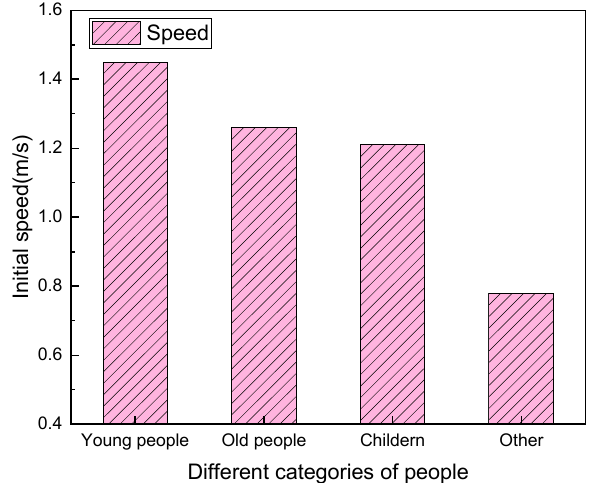
Figure 2. Average speeds of people of different ages.